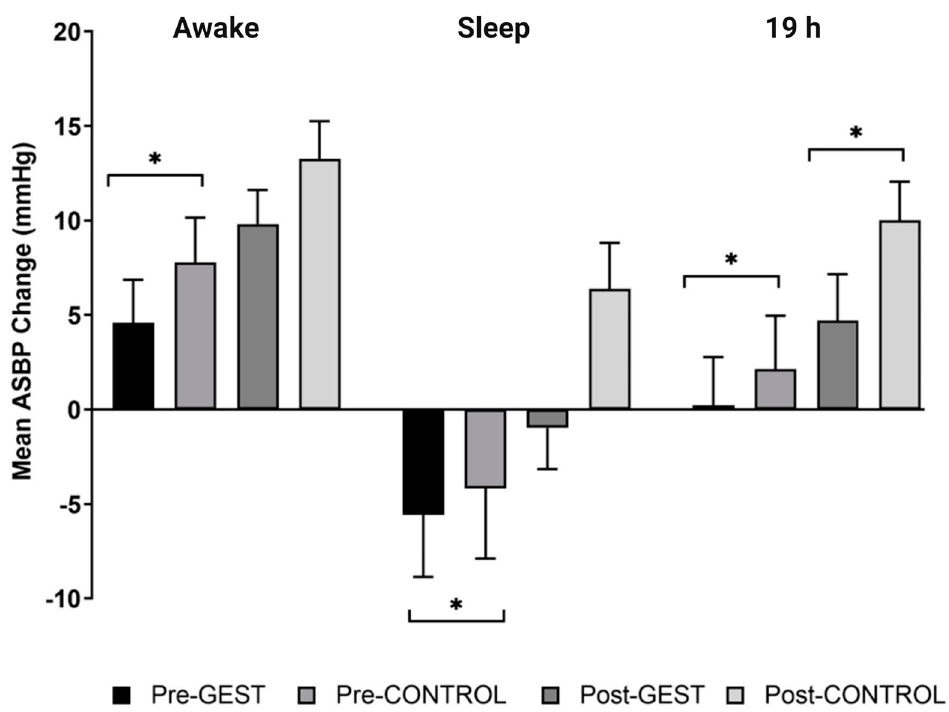
Figure 2. The average ambulatory systolic blood pressure (ASBP) response to the GEST versus CONTROL before and after exercise training over awake, sleep, and 19 h. Pre − GEST: average BP change following the GEST from baseline before the training; Pre − CONTROL: average BP change following CONTROL from baseline before the training; Post − GEST: average BP change following the GEST from baseline after the training; Post − CONTROL: average BP change following CONTROL from baseline after the training; * p < 0.05.